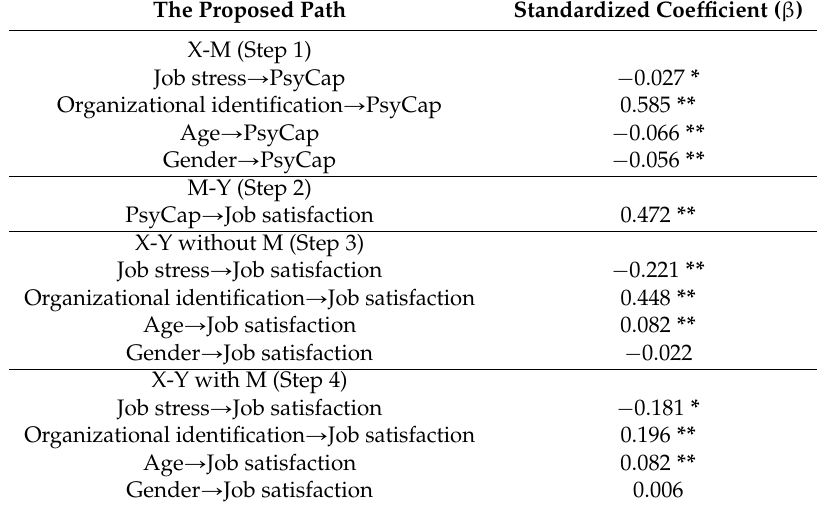
Table 5. Results of the proposed paths in the four models examining the mediating effect of PsyCap. The Proposed